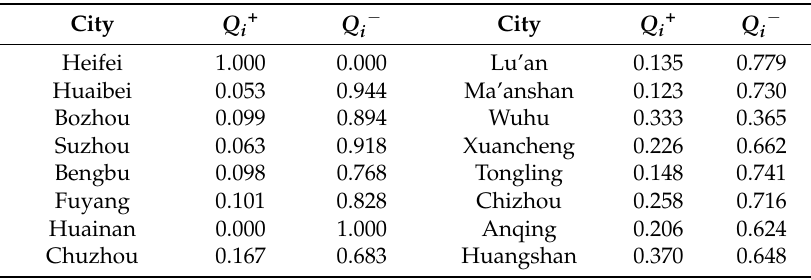
Table 7. Grey relational degree of each city.